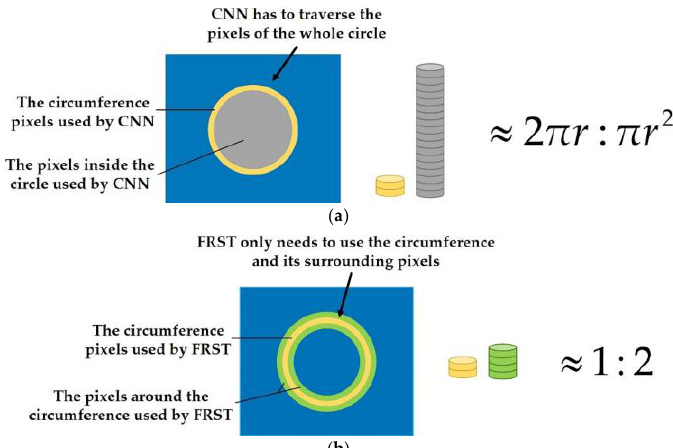
Figure 3. Comparison of the number of pixels traversed by CNN and FRST to process circular objects. ( a ) Comparison of the number of pixels traversed by CNN in processing circular objects; ( b ) comparison of the number of pixels traversed by FRST in processing circular